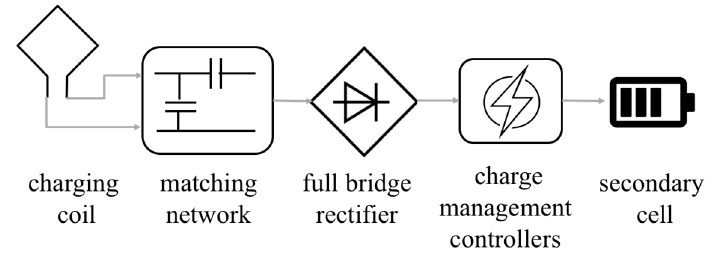
Figure 15. Block diagram of the WPT receiving unit.